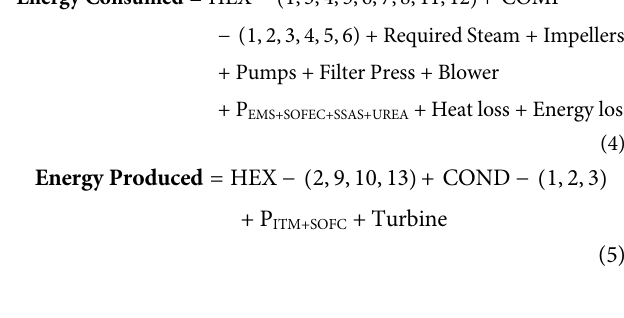
Frontiers in Energy Research |